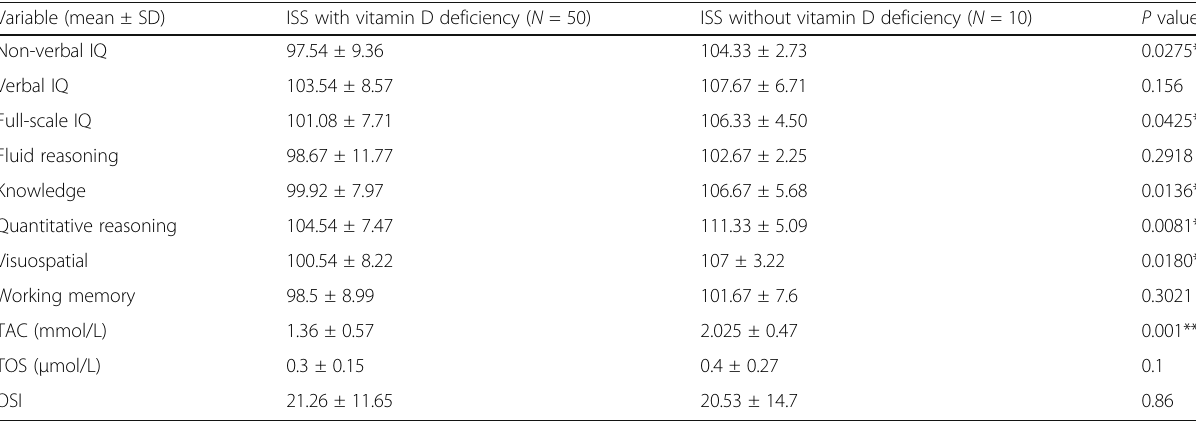
Table 3 Cognitive functions and oxidative stress parameters among children with idiopathic short stature subgroups with and without vitamin D deficiency Variable (mean ± SD) ISS with vitamin D deficiency ( N =